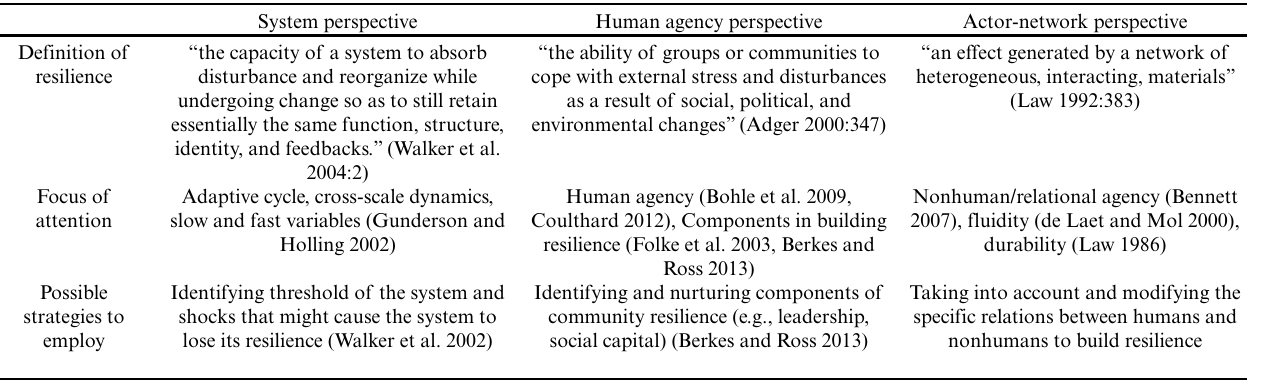
Table 1 . Three different perspectives in understanding